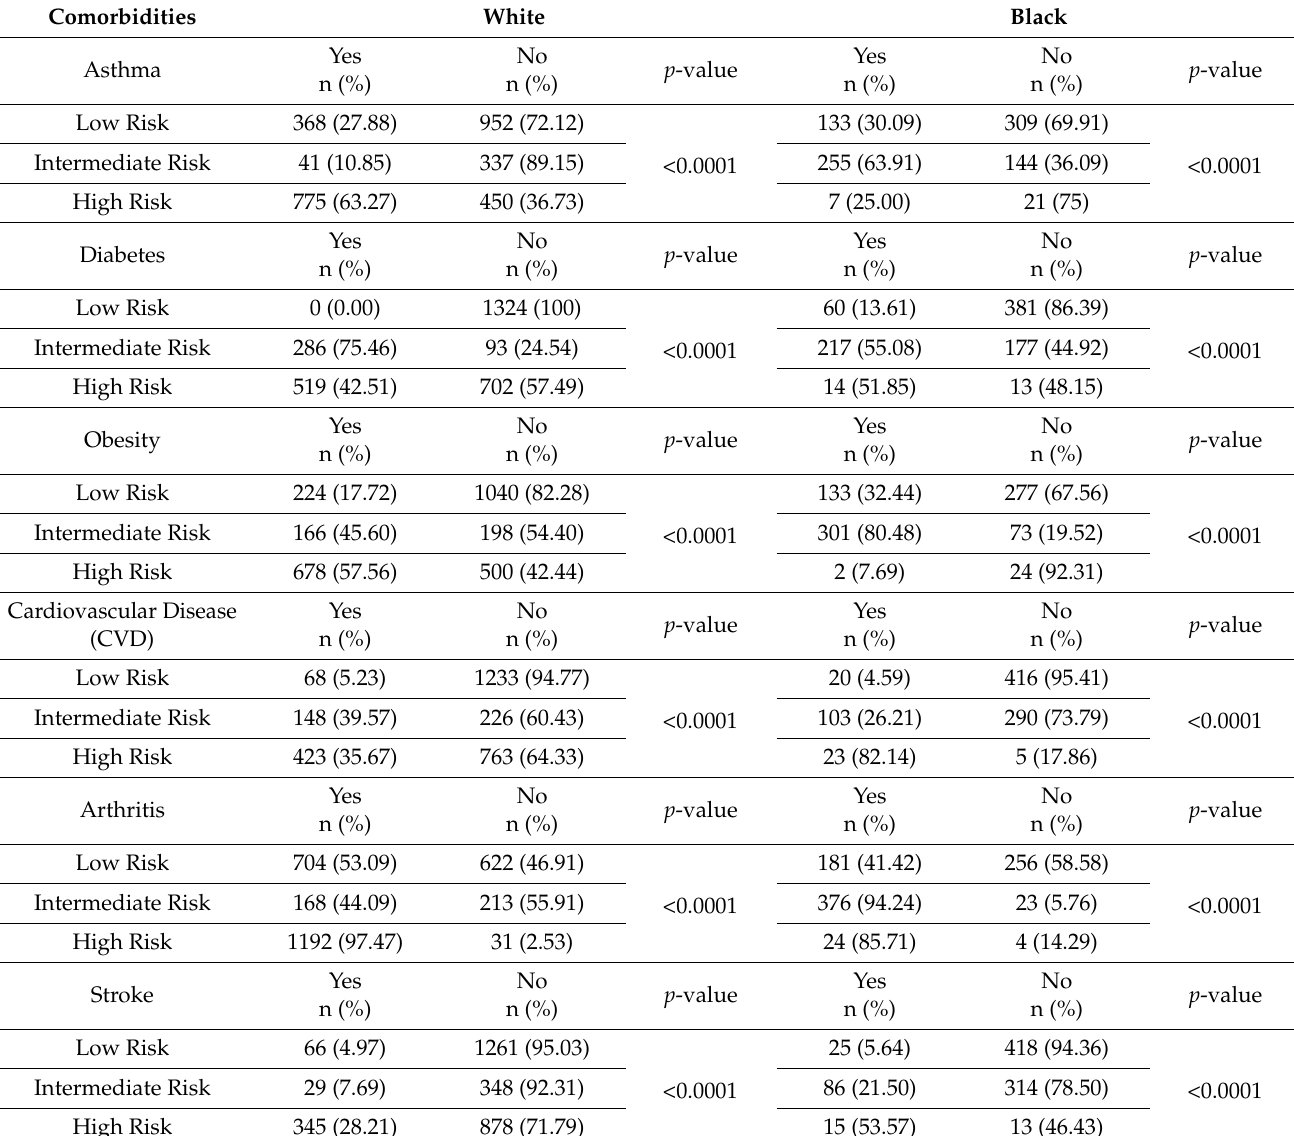
Table 1. Classification frequencies of comorbidity risks for Black and white Alabamians with COPD, BRFSS, 2015–2019. Comorbidities White Black